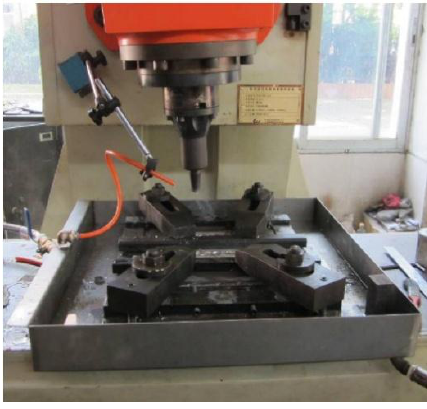
Figure 10. Photograph of the SFSP equipment.